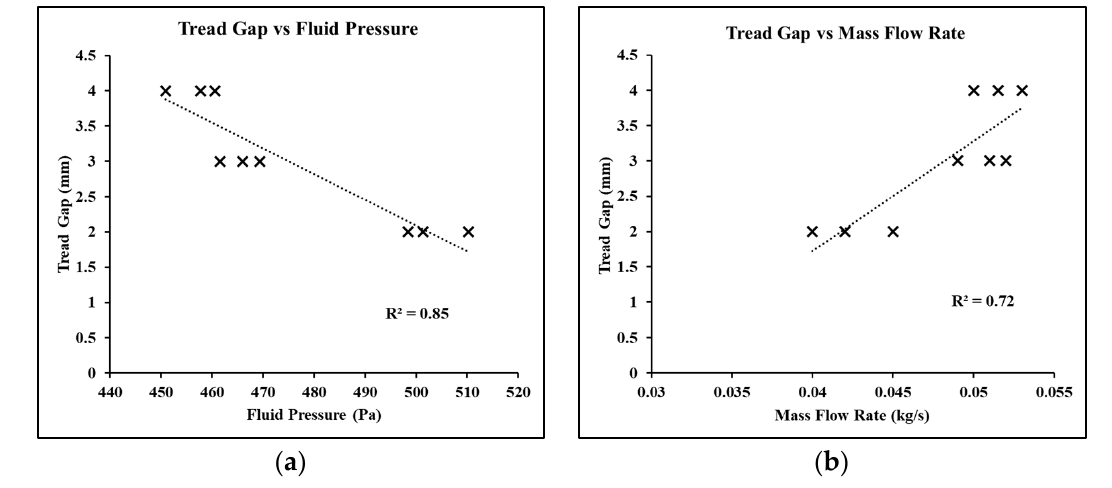
Figure 9. Effect of tread gap on: ( a ) induced fluid pressure and ( b ) mass flow rate.